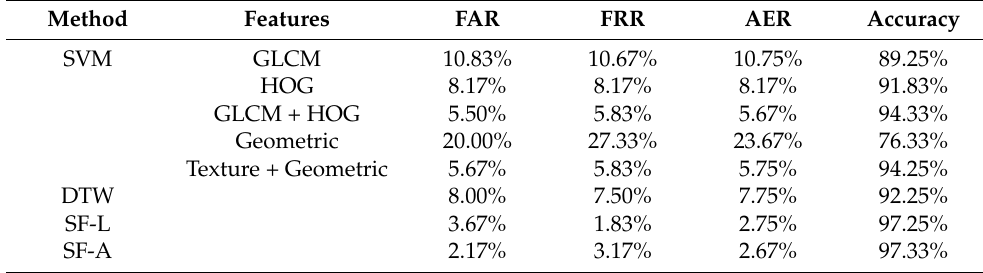
Table 6. The result of eight training